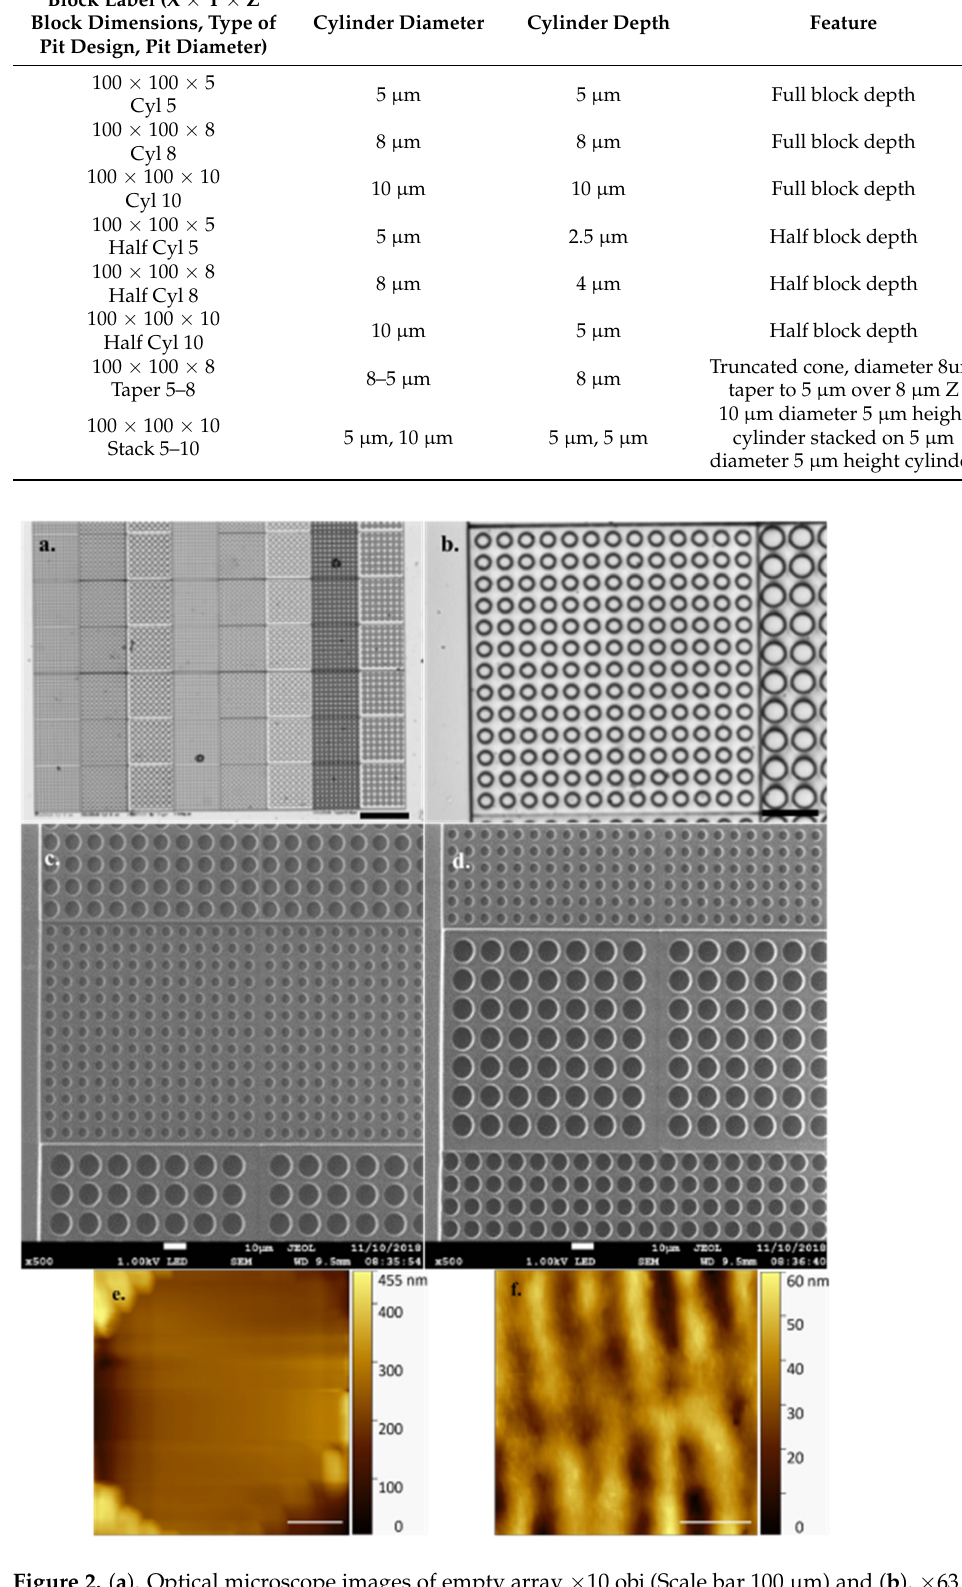
Table 1. Original block designs for designed cell array as seen in Figure 1. Block Label (X × Y × Z Block Dimensions, Type of